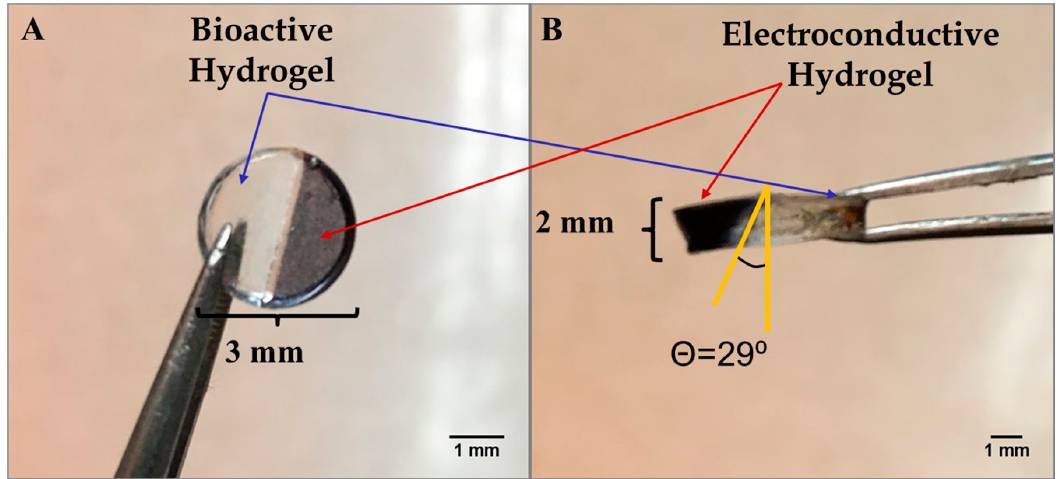
Figure 2. Microlithographic fabrication of a hybrid construct based on the use of photomasks to create adjacent non-conductive p(HEMA- co -HMMA- co -PEGMA) hydrogels and electroconductive (1.00 wt% PAn-PAAMPSA) hydrogels. Hybrid hydrogel disk ( A ) top view and ( B ) side view.